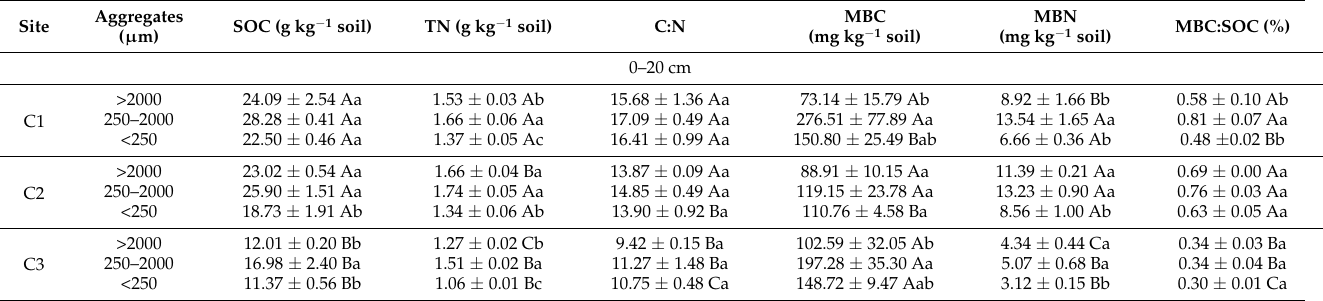
Table 2. Soil organic carbon, total nitrogen, microbial biomass C and N in aggregates in depths of 0–20 cm and 20–40